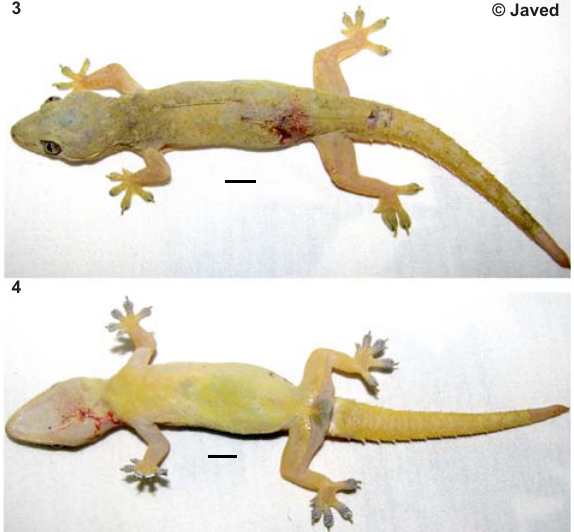
Images 3 & 4. Hemidactylus cf. frenatus male (ZSI/FBRC/V-1521) (live). 3 - Dorsal aspect; 4 - Ventral aspect. Note: The bloody area infected by an unknown parasite.